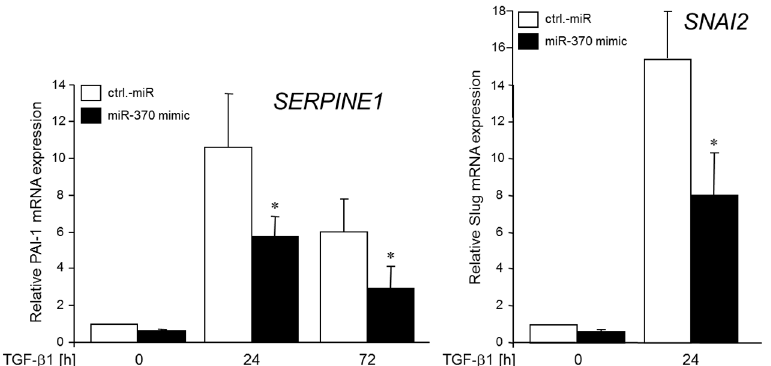
Figure 5. Transfection with a miR-370-3p mimic decreases TGF β 1-induced expression of PAI-1 and SLUG. Panc1 cells were transiently transfected with 50 nM of control (ctrl) miR or a miR-370-3p mimic and 48 h later remained unstimulated (0) or were stimulated with TGF β 1 (5 ng/mL) for 24 or 72 h (PAI-1), or 24 h (SLUG). Cells were examined for PAI-1- and SLUG- expression by qPCR. Data represent the mean ± SD of three independent experiments ( n = 3). The asterisks (*) indicate significance relative to control ( p <